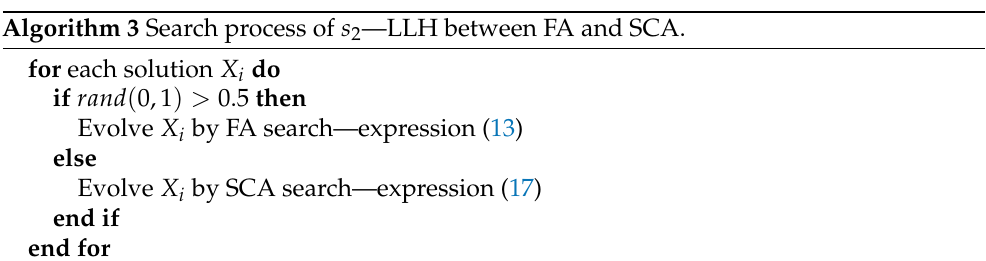
Algorithm 3 Search process of s 2 —LLH between FA and